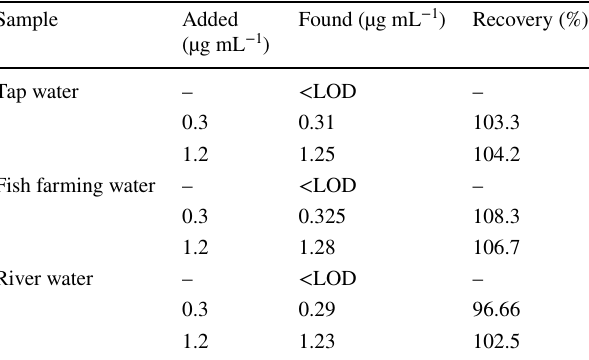
Table 7 Preconcentration and spectrophotometric determination of BG in the spiked water samples by the proposed method